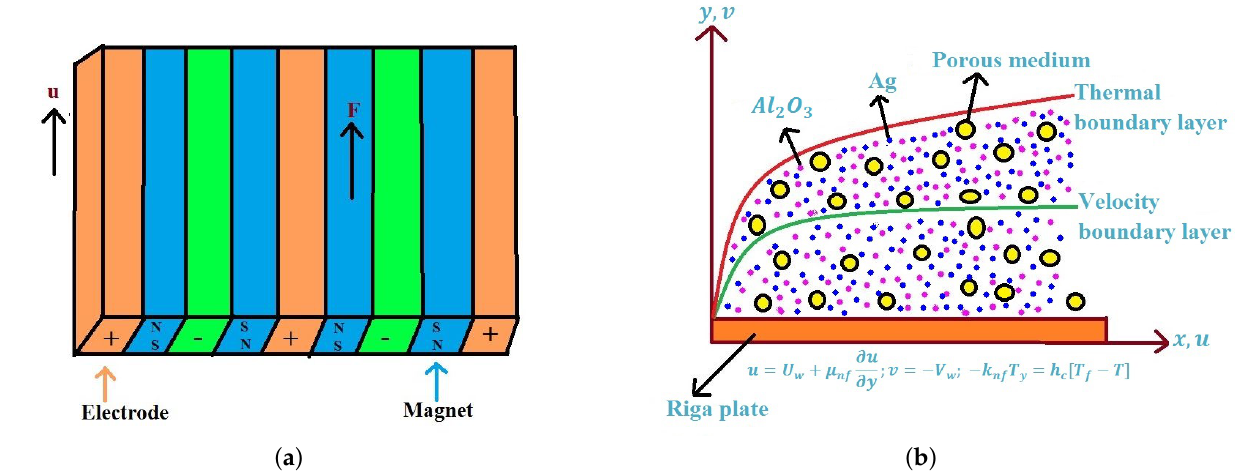
Figure 1. ( a ) Sketch of a Riga plate and ( b ) physical configuration of the flow